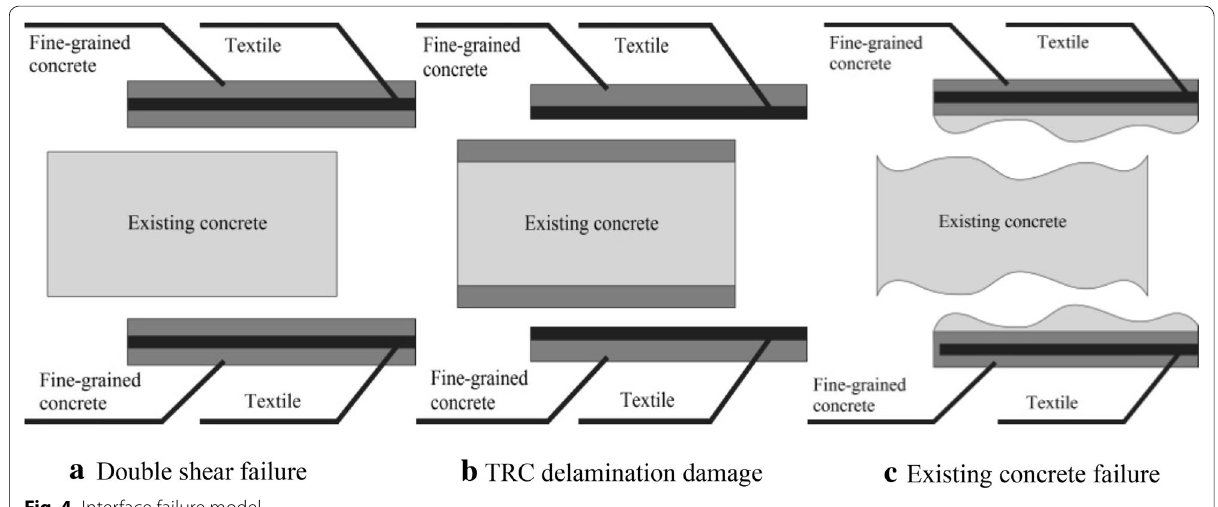
Fig. 4 Interface failure